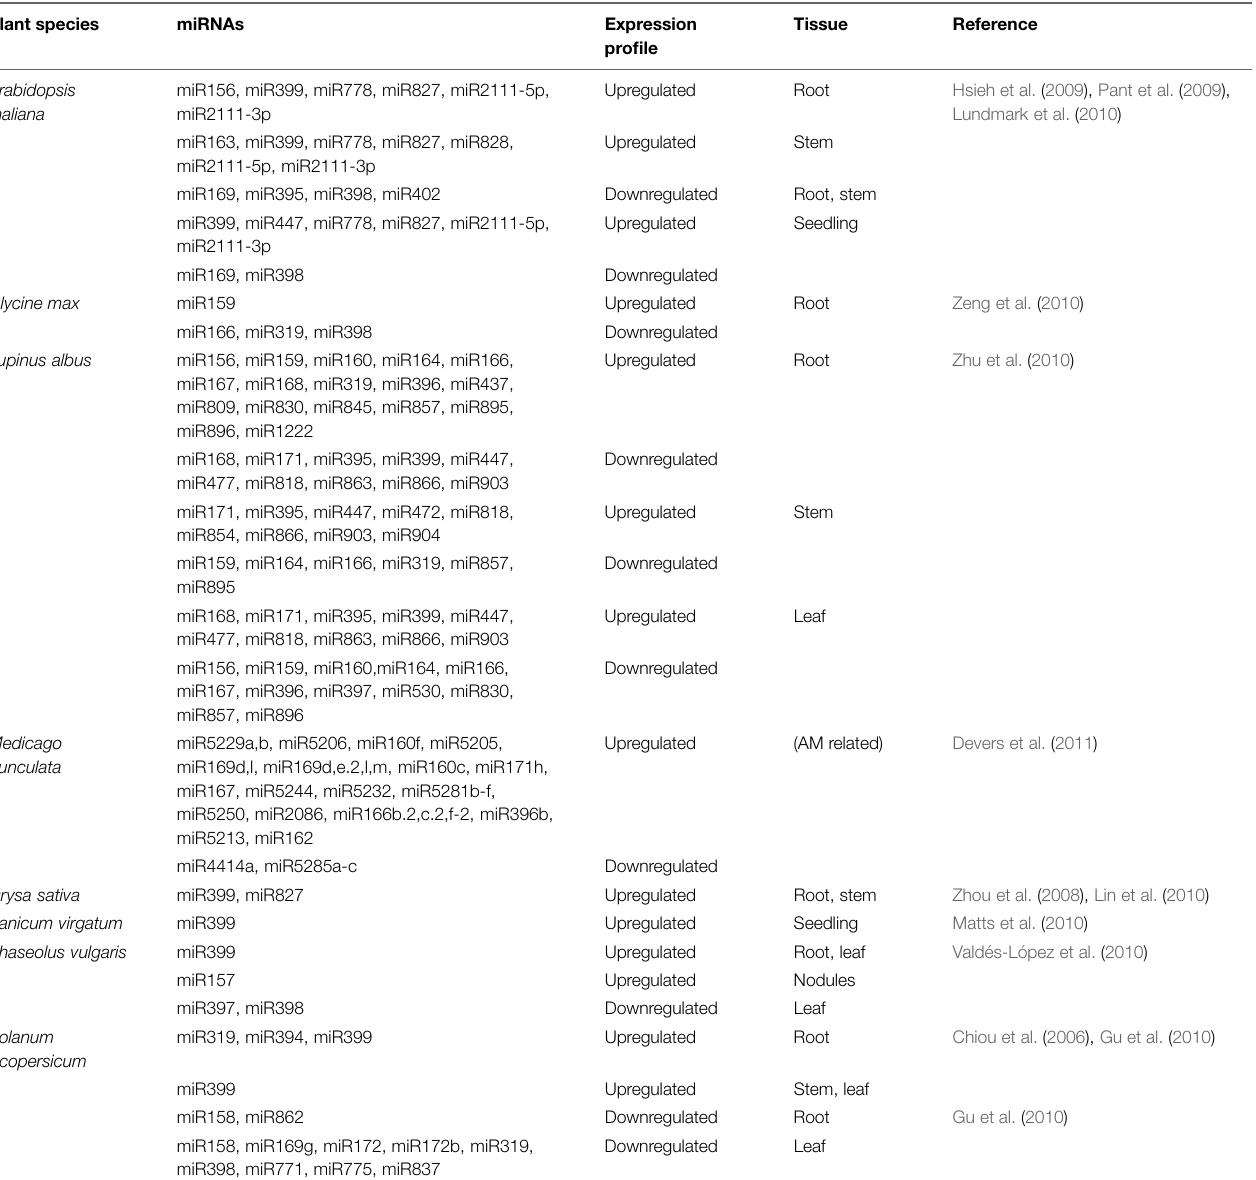
TABLE 2 | P-responsive miRNAs with respective expression profiles in different tissues and species during